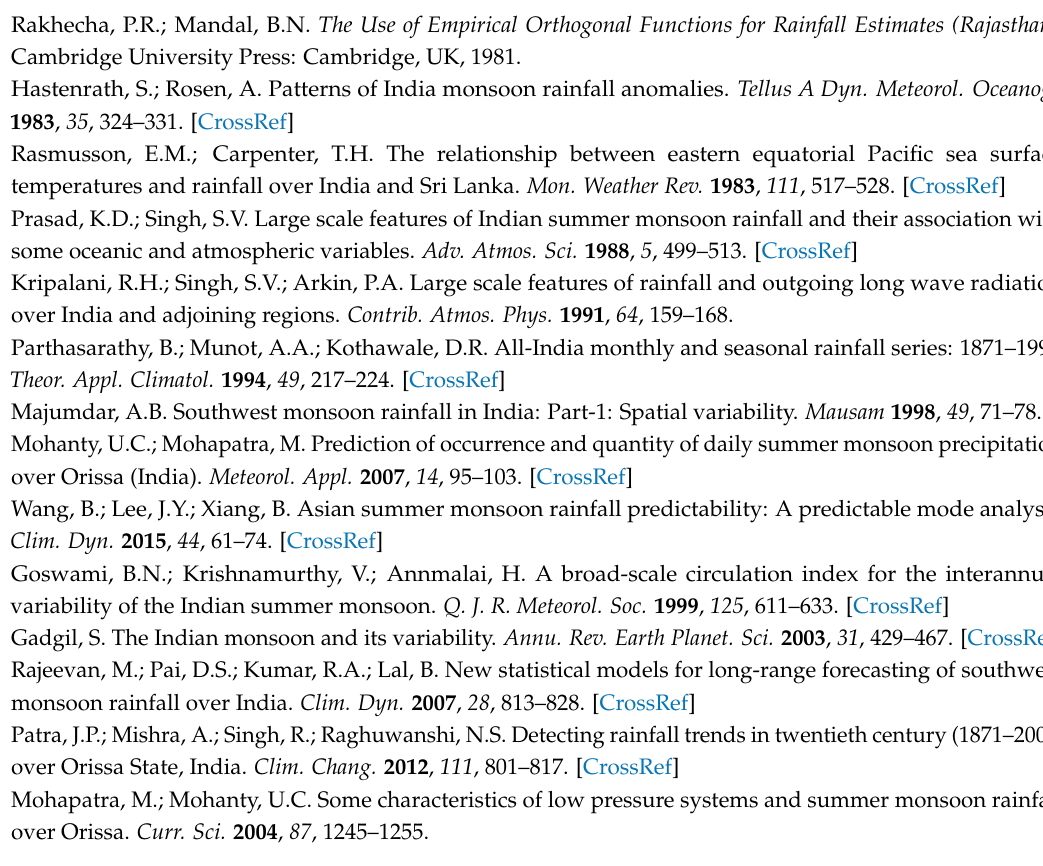
Figure S1: Relationship of (a) annual and (b) monsoon rainfall over India and